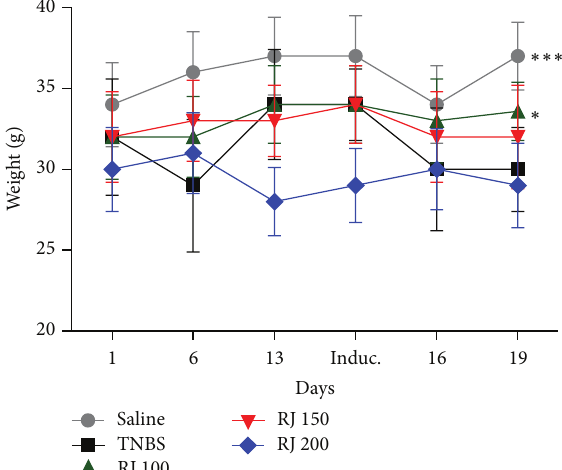
Figure 1: Weight means of the 5 different groups on days 1, 6, and 13 (before induction) and 16 and 19 (after induction). Data is presented as mean ± SEM. Two-way ANOVA followed by Bonferroni’s 𝑡 -test. ∗ 𝑃 < 0.05 , ∗∗∗ 𝑃 < 0.001 are significantly different from TNBS